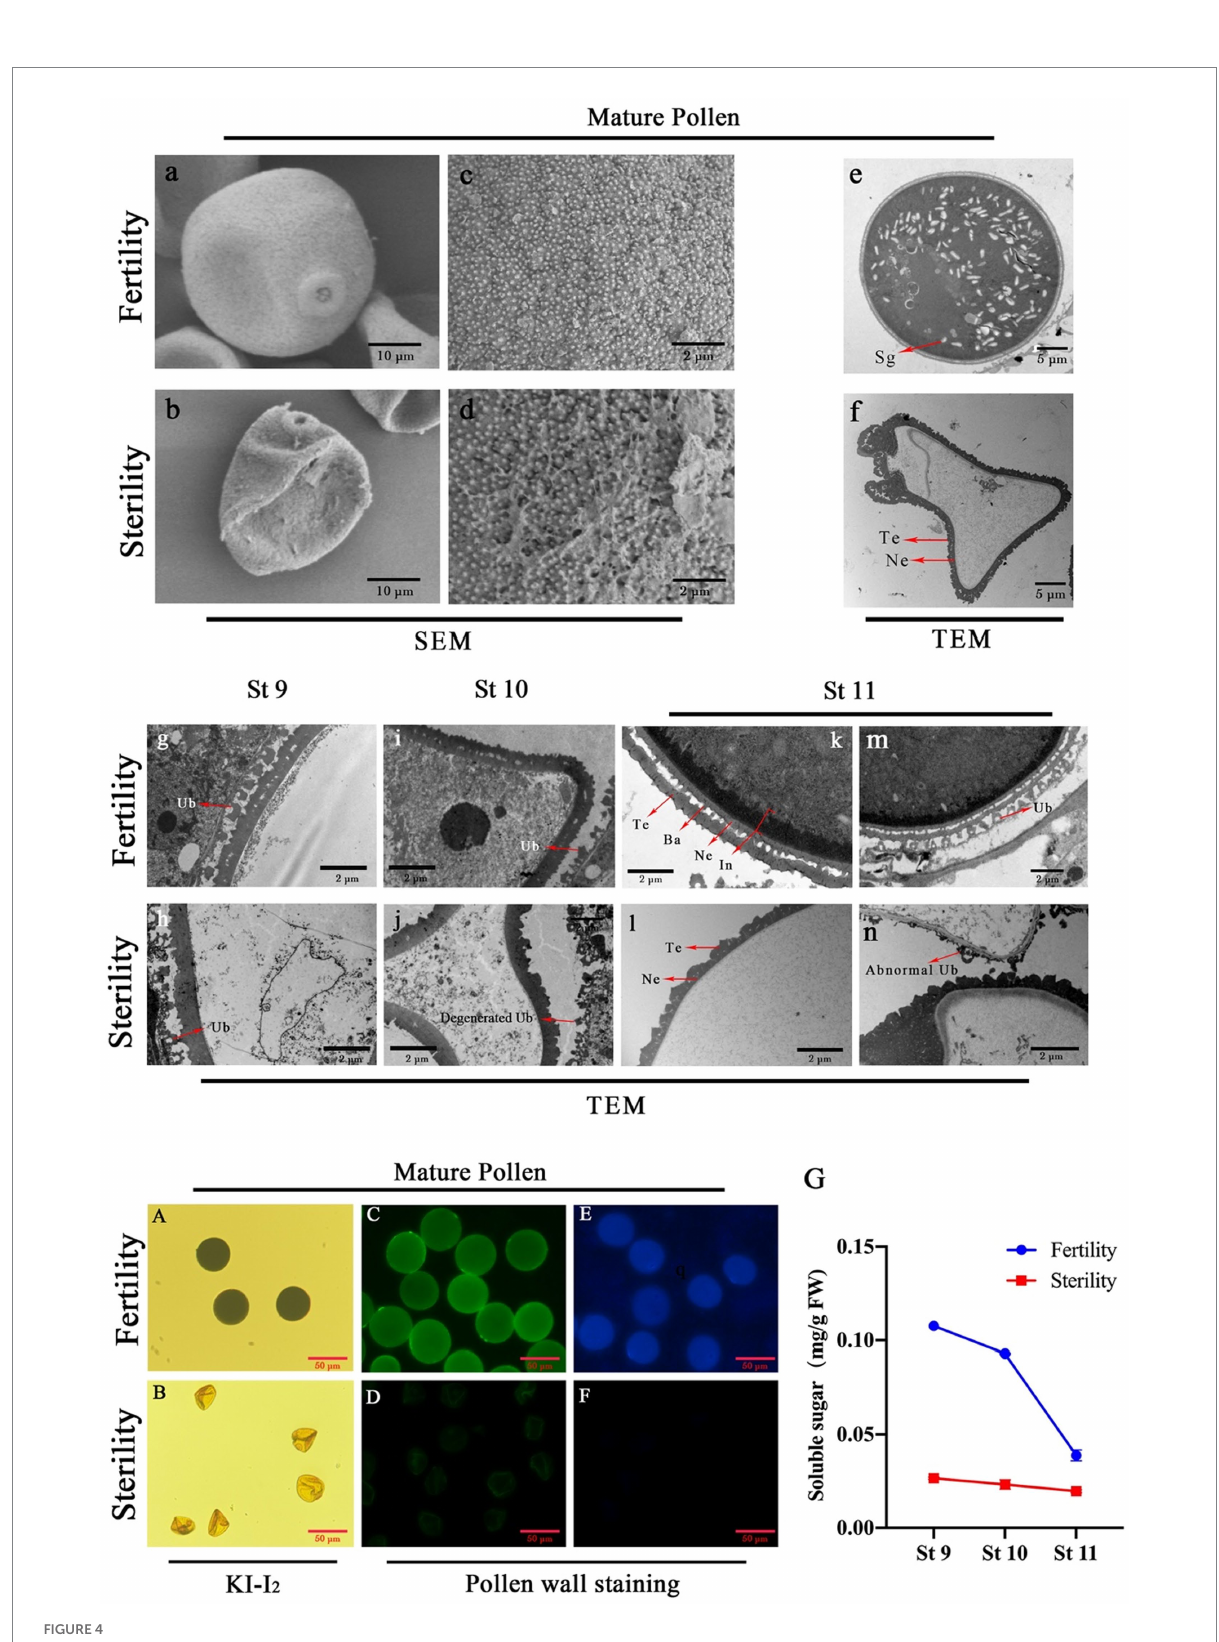
FIGURE 4 Observation of pollen grain structure via electron microscopy and staining. Electron microscopic observation of fertility a, c, e and sterility b, d, f pollen grains. TEM observation of the pollen wall structure in fertility g, i, k, m and sterility h, j, l, n . Pollen stained by KI-I 2 A, B , Auramine O C, D and Calcofluor White E, F ; Soluble sugar contents G in fertility and sterility plants. Ub, Ubisch body; Te, texine; Ba, bacula; Ne, nexine; In, intine; Sg, starch